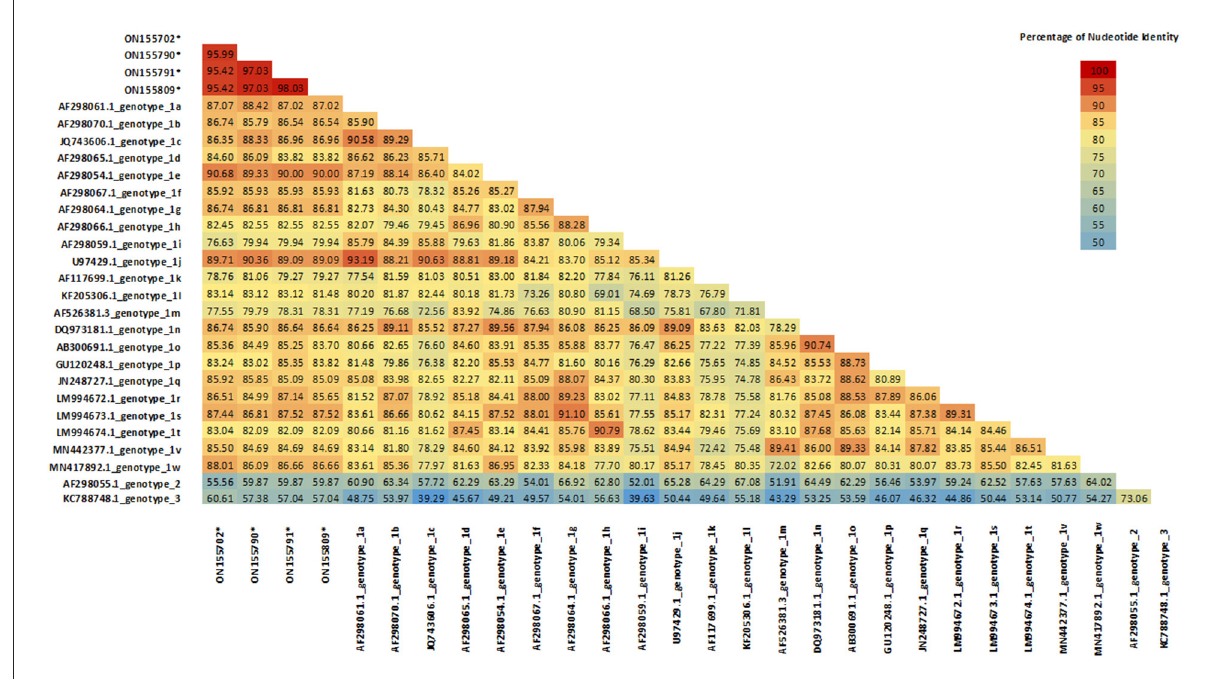
FIGURE3 Sequence Identity Matrix of 1x strains compared with currently known Pestivirus A genotypes. Values generated from the 221-bp alignment of the 5 ′ UTR segment. Sequences belonging to 1x genotype were compared with 24 reference strains of BVDV (one per known